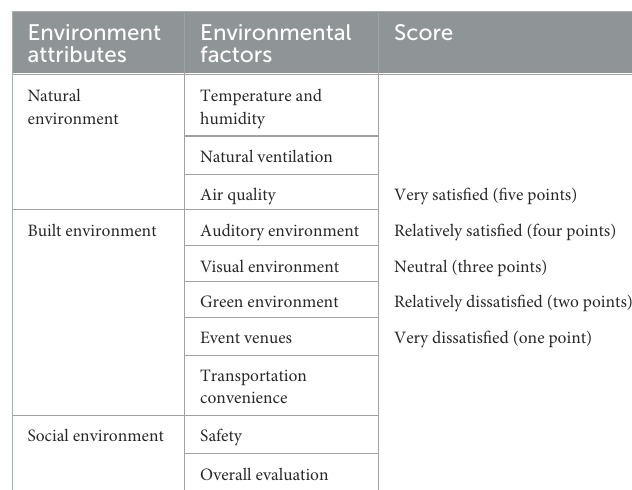
TABLE 1 Subjective environmental comfort